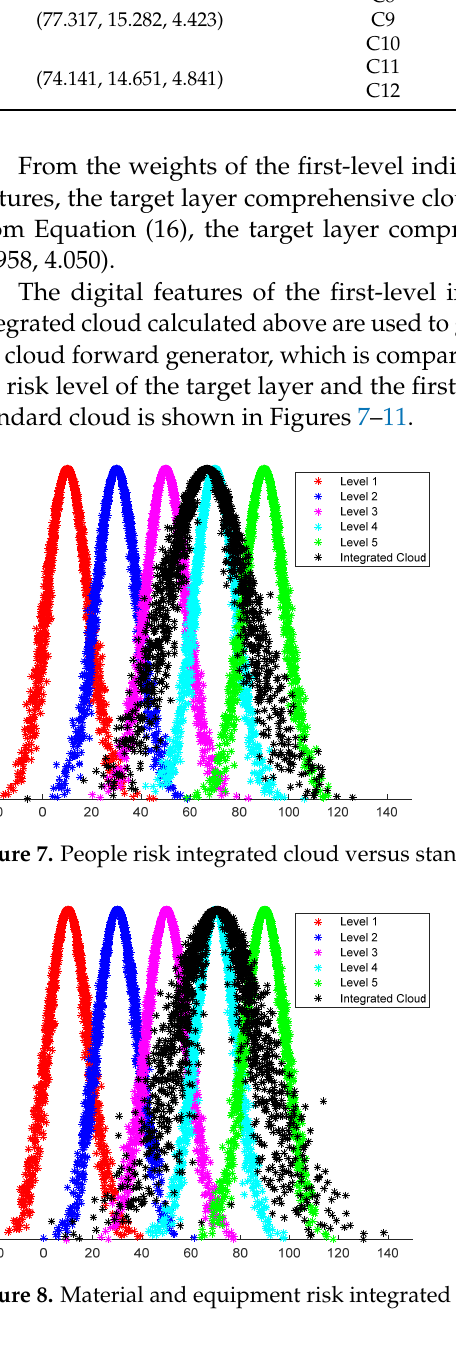
Figure 9. Construction environmental risk integrated cloud vs. standard cloud. -20